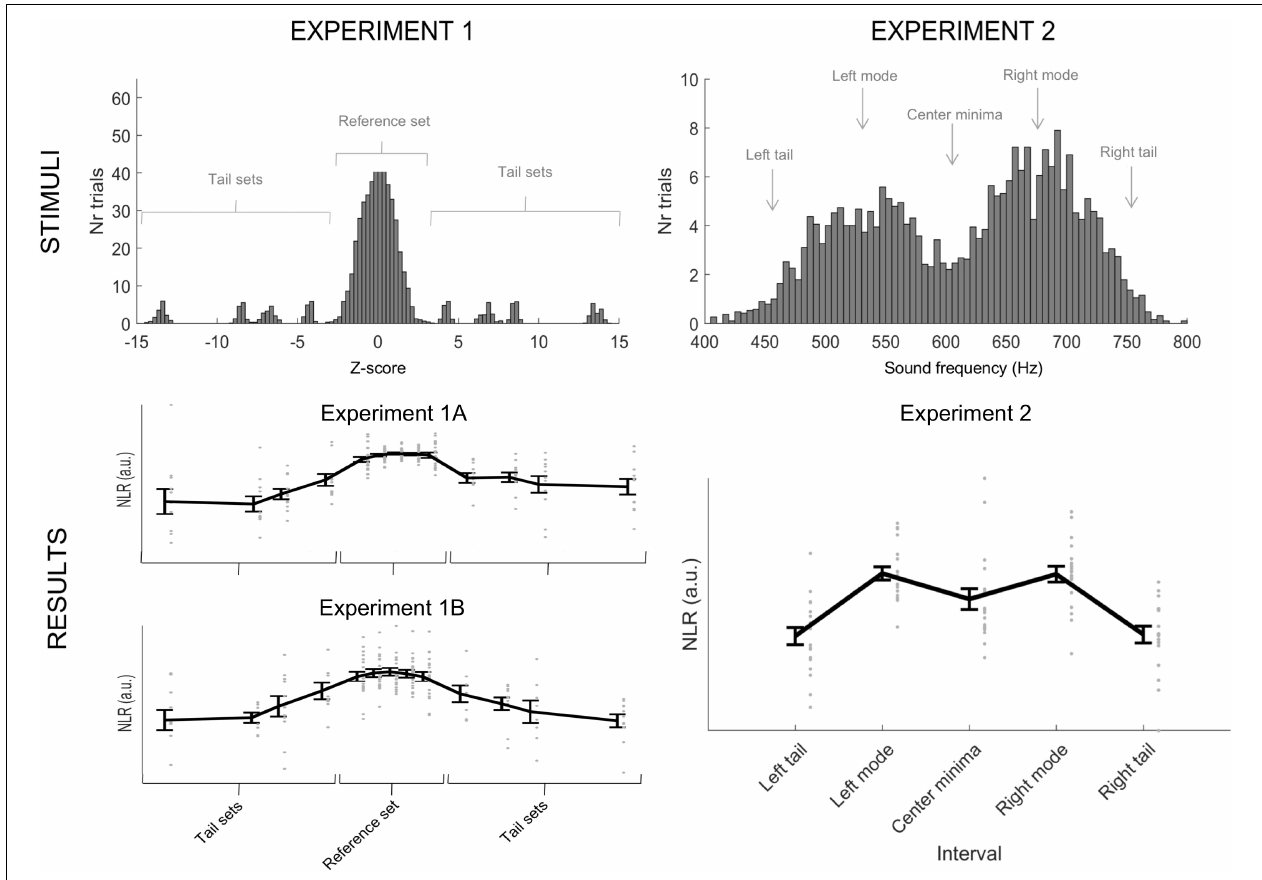
FIGURE 1 | Illustration of stimuli and results for Experiments 1A, 1B, and 2, respectively. (Top) Histogram of the auditory stimuli presented to participants in Experiments 1 (1A and 1B) and 2, respectively. In Experiment 1A and 1B, we presented a total of 620 tones, 500 tones from a reference set, and 120 tones from four tail sets (30 from each distribution). Thus, tones from the tail sets were equally frequent. The histogram illustrates stimuli collapsed over all references sets used and their corresponding tail sets. In Experiment 2, we presented a total of 500 tones that followed a bimodal distribution. The figure includes an illustration of the two tails’ position, modes, and the center minima used to analyze the data from Experiment 2. (Bottom) Individual data points from Experiment 1A, Experiment 1B, and Experiment 2, respectively, with the mean and standard error (whiskers). The figure depicts the negative normalized NLR. In Experiment 1A and 1B, the individuals’ responses resemble a normal curve, and the response to the tail sets is not categorically flat. In Experiment 2, the brain responses flexibly mirror the presented stimuli and not a normal